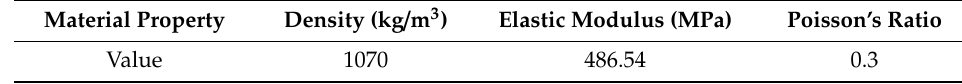
Figure 2. Numerical analysis: ( a ) tensile test model and ( b ) results. Table 2. Mechanical properties of the waterproof membrane.